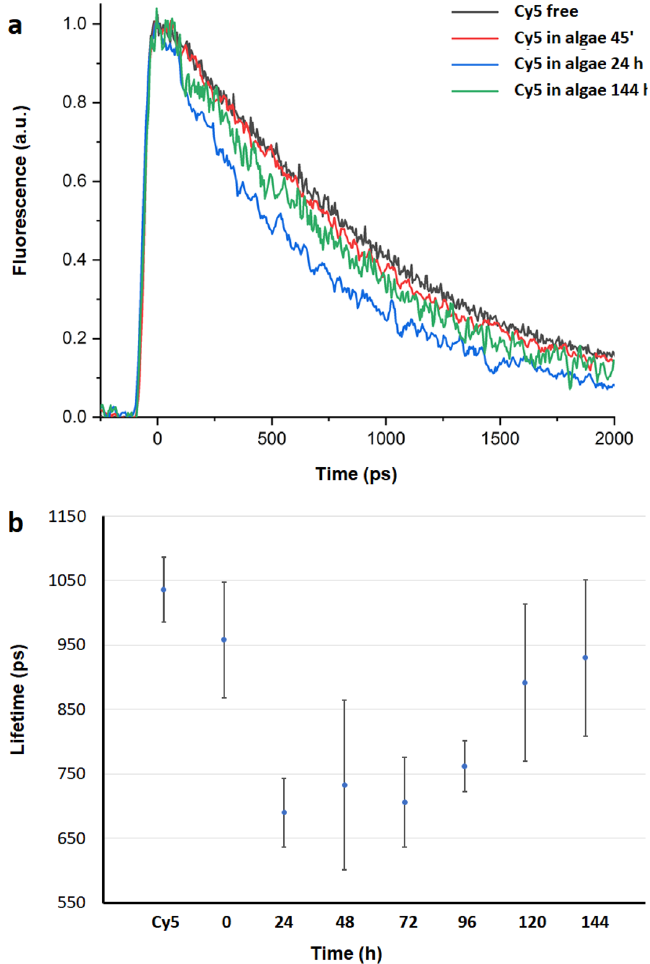
Figure 6. ( a ) Temporal evolution of Cy5 alone and inside diatoms at different incubation times. ( b ) Evolution of the fluorescence lifetime decay of Cy5 alone and incorporated into diatoms after different incubation times.